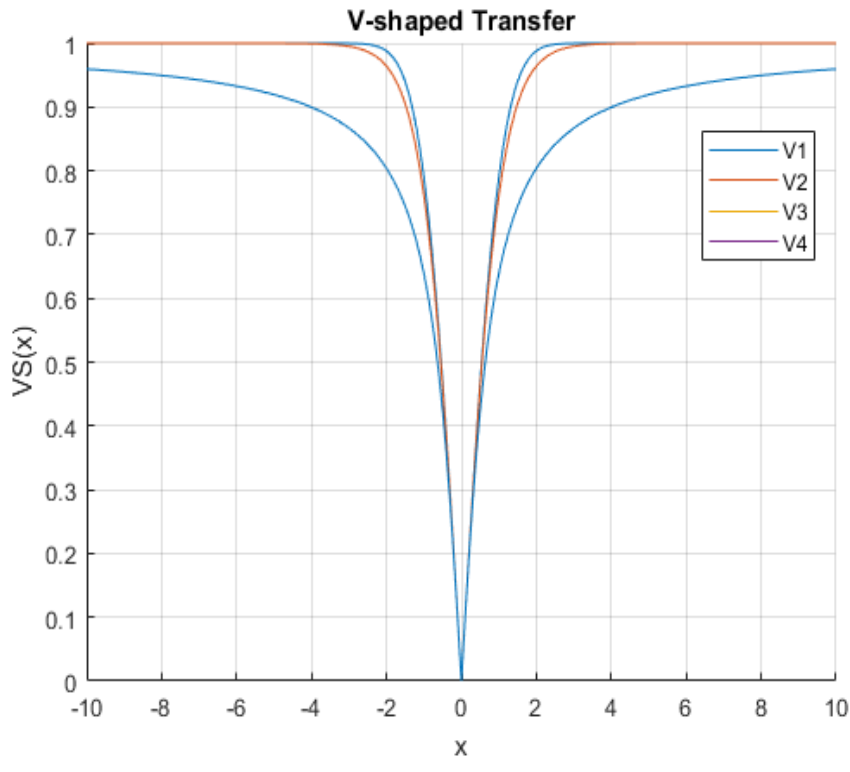
Figure 4. A graphic view of various types of V-shaped transfer function. In the BAOVAS version, the solution V t +1 is transferred from the continuous state i